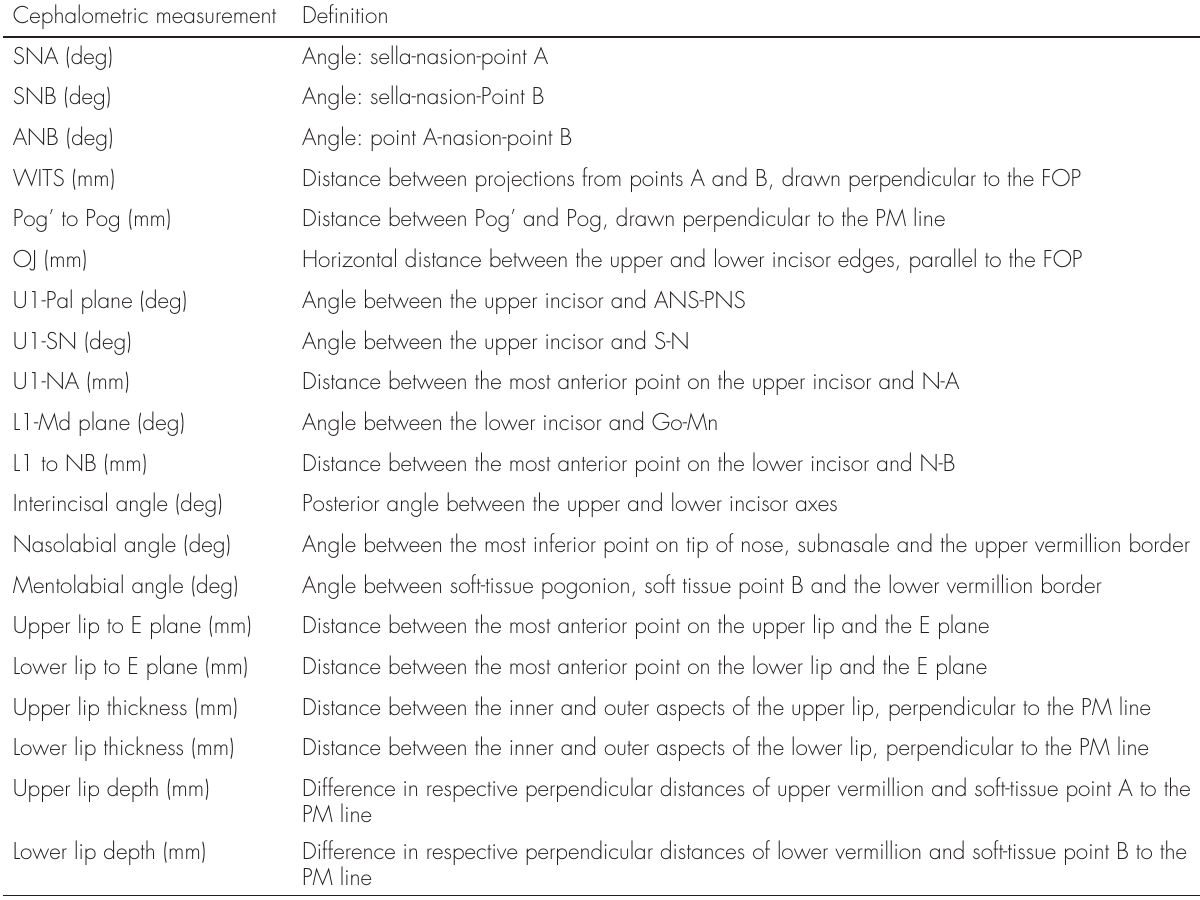
Table II. Definitions of lateral cephalometric